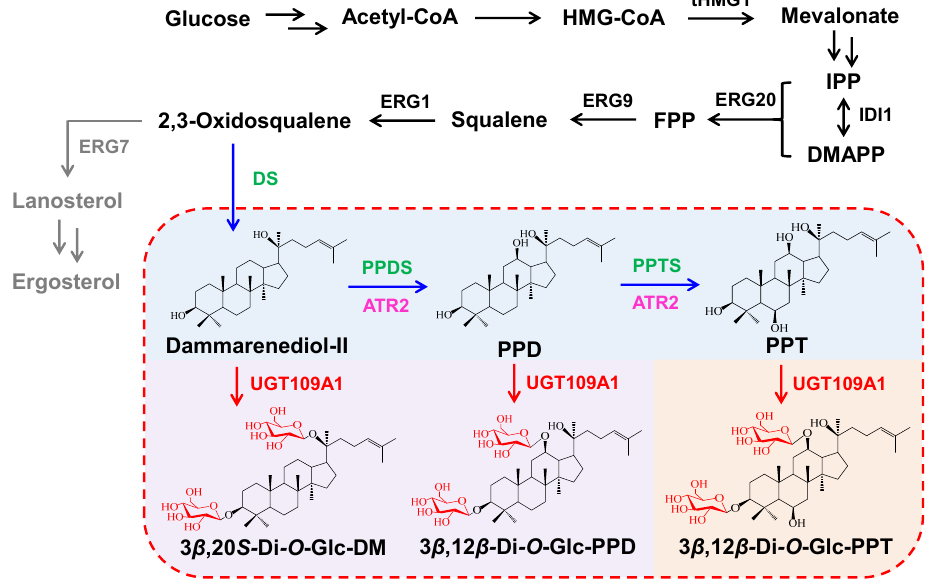
Figure 1. Construction of the biosynthetic pathway of 3 β ,12 β -Di- O -Glc-PPT in the engineered yeast. The intrinsic Saccharomyces cerevisiae pathway is indicated by black and grey arrows. The double arrows show the multiple-step reactions. The Panax ginseng pathway is shown by blue arrows; the glycosylation reactions are shown by red arrows. The genes in black are up-regulated; the gene in grey is down-regulated; the genes in green are from P. ginseng ; the gene in magenta is from Arabidopsis thaliana ; and the gene in red is from Bacillus subtilis . The compounds in blue background are aglycones; the compounds in purple background are by-products; and the compound in orange background is target